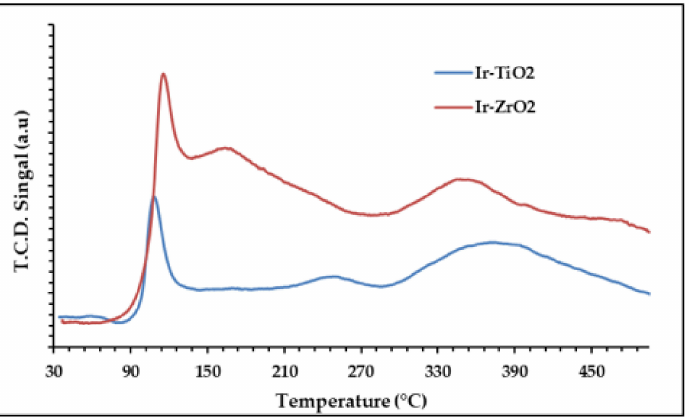
Figure 4. Temperature programmed reduction (H 2 -TPR) profiles of the Ir-TiO 2 and Ir-ZrO 2